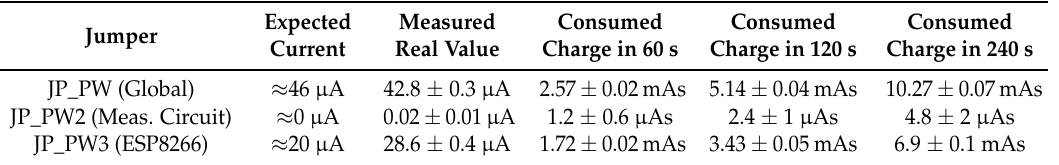
Table 3. Consumption in the “waiting between measurements” state. The real values are the average result of 15